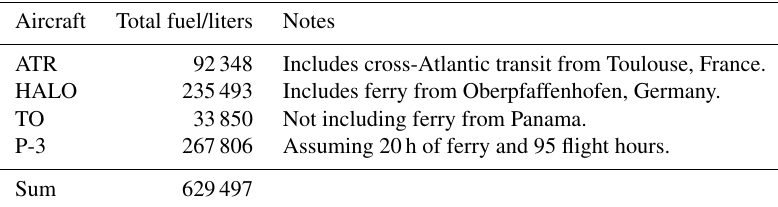
Table A1. Fuel consumption from EUREC 4 A crewed aircraft. Some fuel burn rates were reported in pounds (lb) and were converted to liters using a conversion of 1.76lbL − 1 . Aircraft Total fuel/liters Notes ATR 92348 Includes cross-Atlantic transit from Toulouse, France. HALO 235493 Includes ferry from Oberpfaffenhofen, Germany. TO 33850 Not including ferry from Panama. P-3 267806 Assuming 20h of ferry and 95 flight hours. Sum